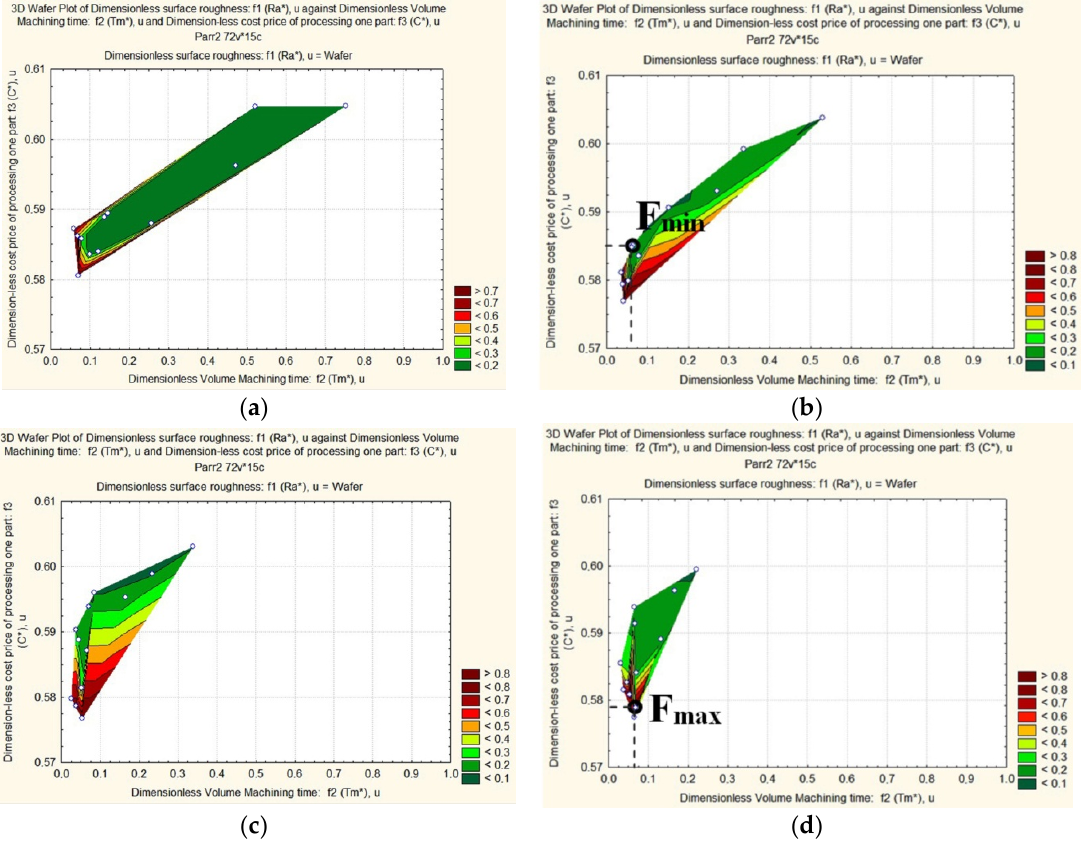
Figure 9. Surface projections of Ra * values depending on the change in the values of C * and T m * at a fixed depth of cut (ECAP-2 hardening of an AA6061 alloy workpiece): ( a ) a p = 0.1 mm; ( b ) a p = 0.2 mm; ( c ) a p = 0.3 mm; ( d ) a p = 0.4 mm.